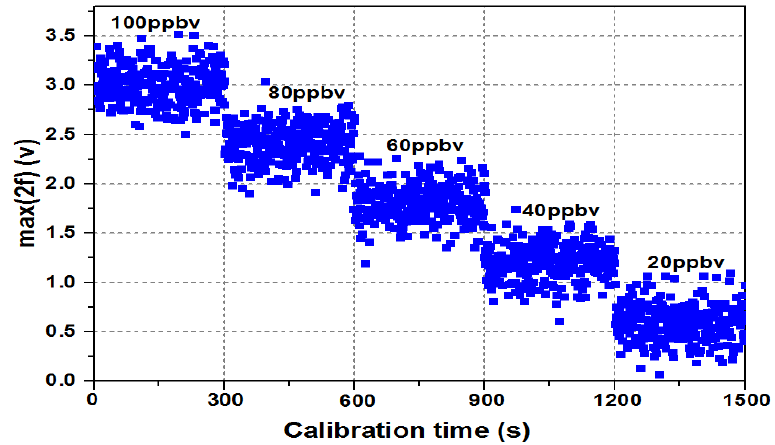
Figure 3. Max (2 f ) at different concentrations.